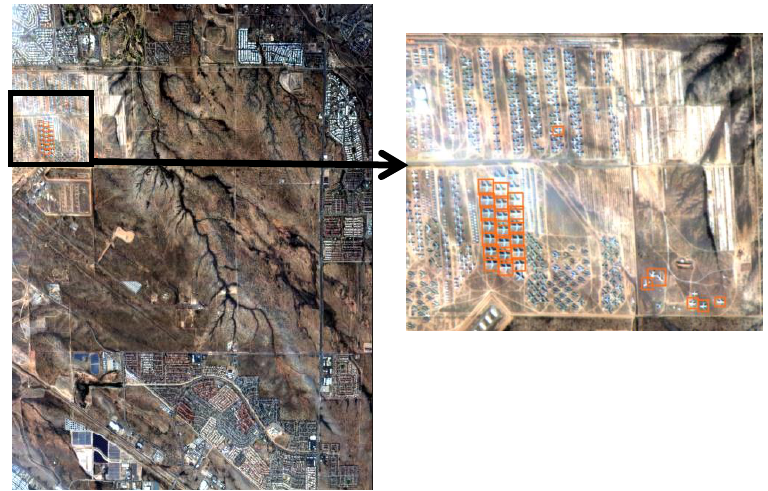
Figure 10. The detection performance for aircraft with the original Yolov5 in the original satellite image.